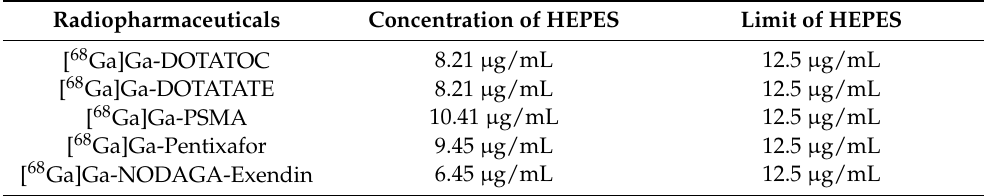
Table 3. Residual content concentration of HEPES in [ 68